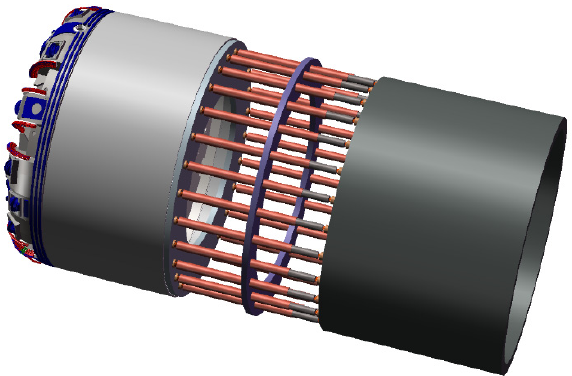
Figure 5. The virtual prototype model of shield machine. The position and attitude should keep changing continuously and smoothly when the shield machine is advancing, and satisfy the coordination of position and attitude with consideration of the coupling. Moreover, the target pose point on the desired trajectory should be within the workspace of the shield thrust mechanism. The parametric equations of driving function for target pose were solved based on Equation (37) and further plotted, as shown in Figure 6.